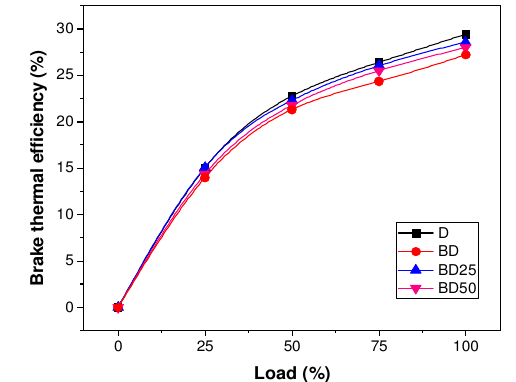
Fig. 3: Influence of engine load on BTE with diesel and Jatropha biodiesel